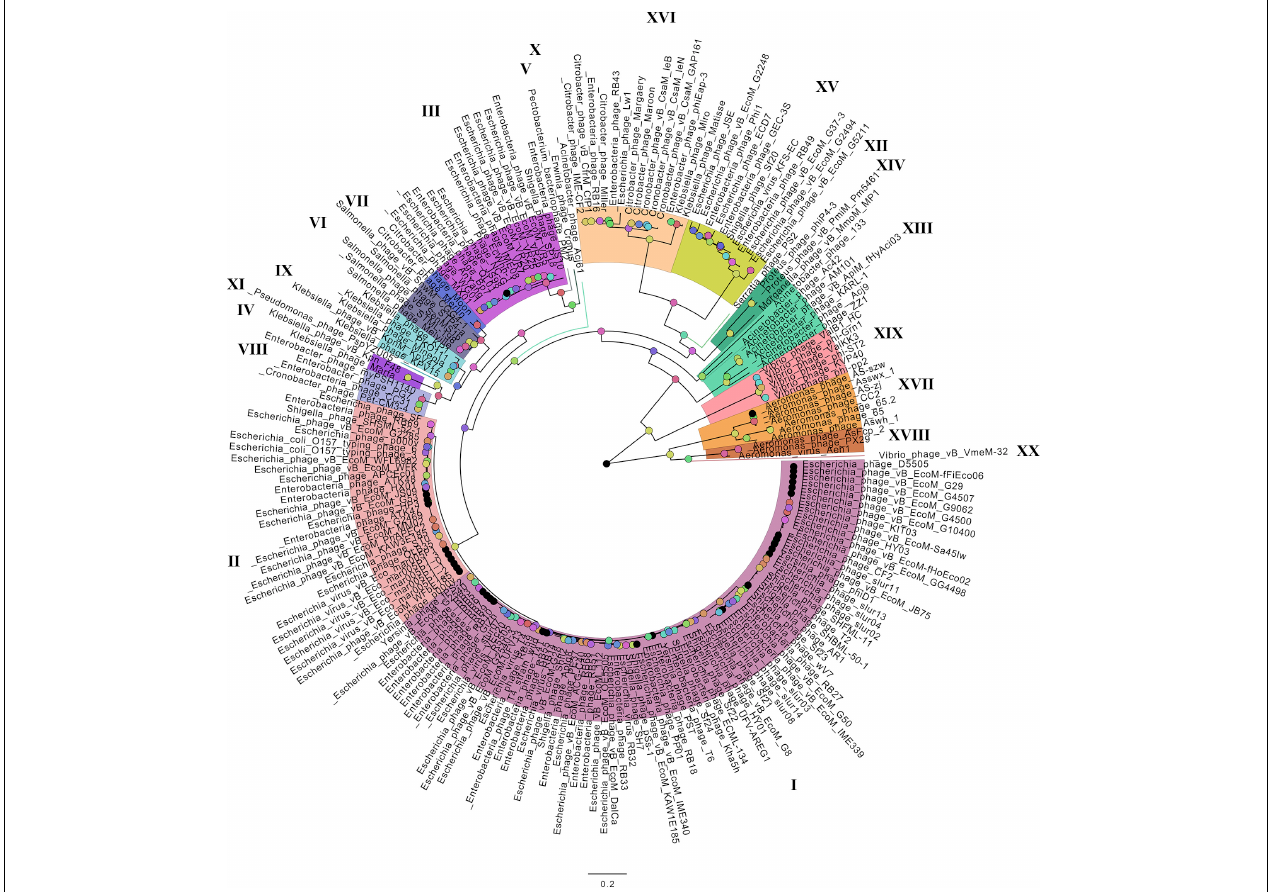
FIGURE 2 | The phylogenetic tree of the main head protein of Tevenvirinae . Selective clades are marked with Roman numerals and colors. The statistical values presented along with the tree in Supplementary Figure 3 are marked with colored